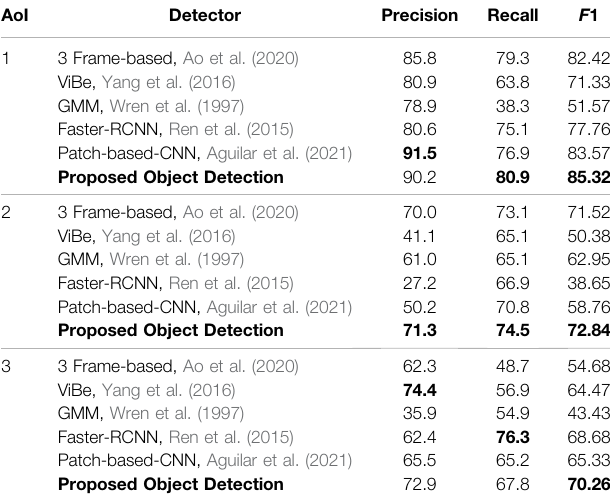
TABLE 3 | Object detection metrics. AoI Detector